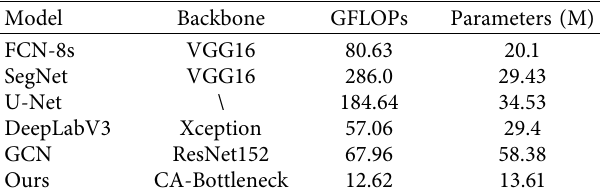
Table 4: Parameter comparison of our method against other state- of-the-art methods on the Insulator test dataset. GFLOPs are es- timated for input of 3 × 512 ×